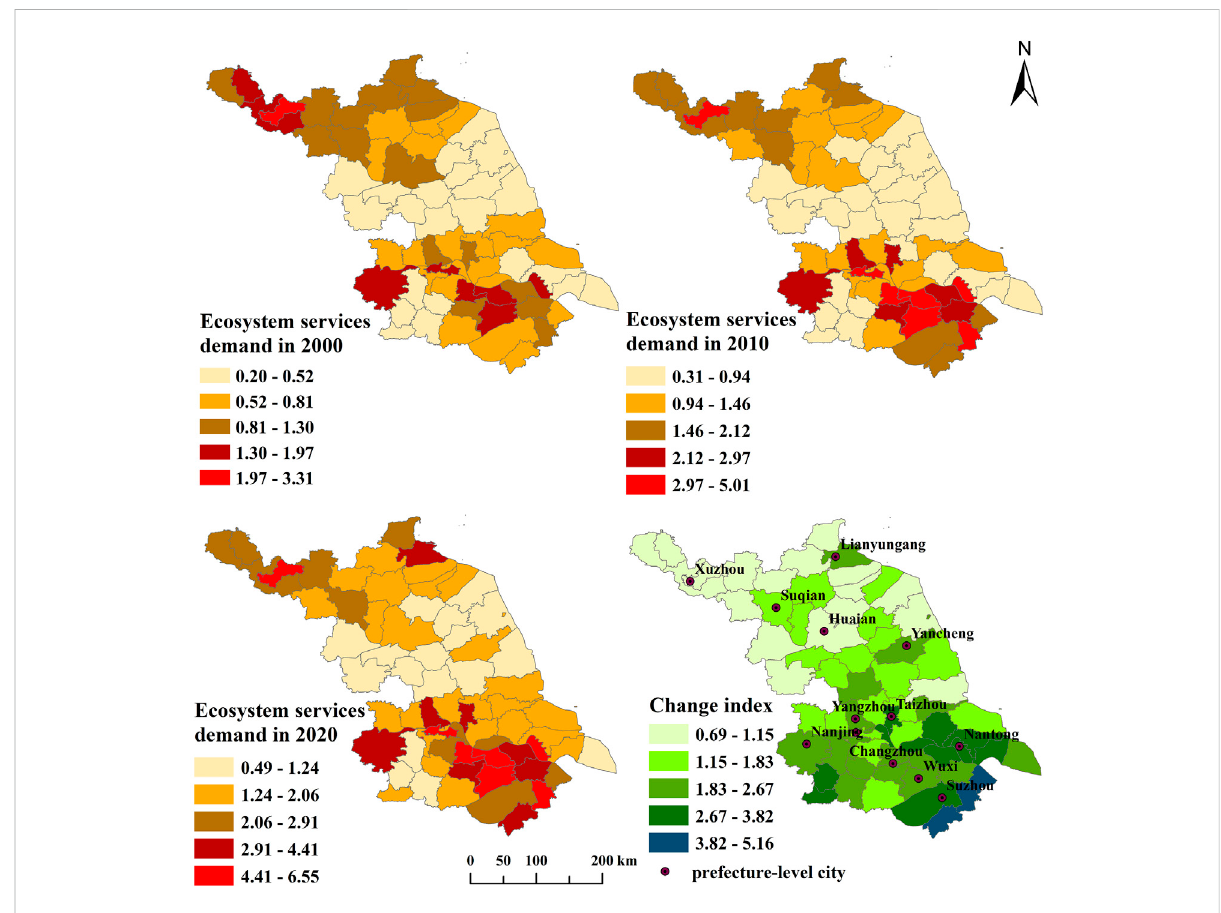
FIGURE 4 Distribution pattern and changes in ecosystem service demand in Jiangsu Province from 2000 to